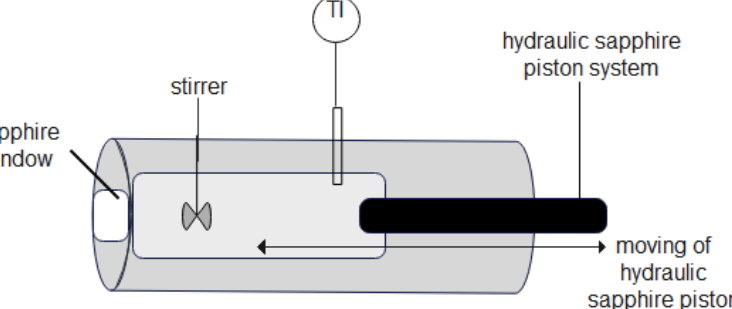
Figure 2. Side view of a scheme of a variable-volume high-pressure optical view cell with a hydraulic sapphire piston system [24].